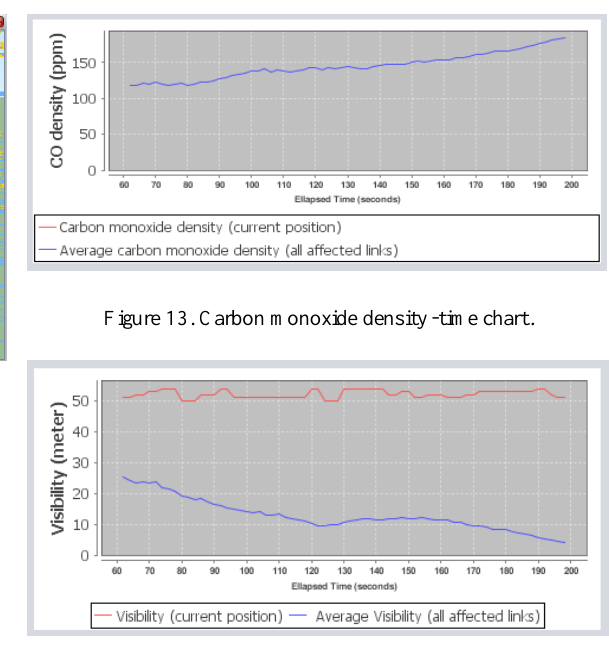
Figure 14. Visibility-time